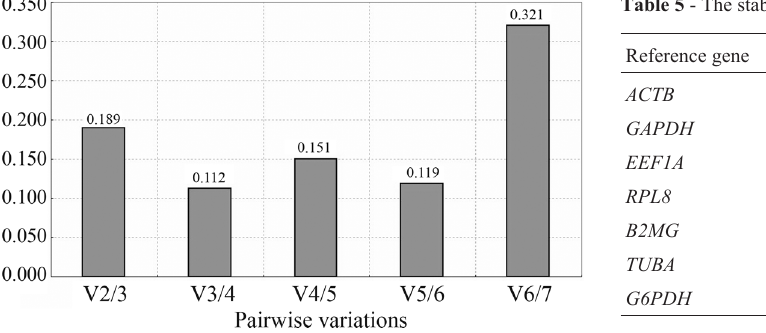
Figure 2 - Determination of the optimal number of reference genes for normalization. The program calculates the V n / n +1 between two sequential normalization factors. Using the cut-off value V = 0.15, three genes were required for accurate normalization under this condition. The three refer- ence genes were ACTB, TUBA and EEF1A.